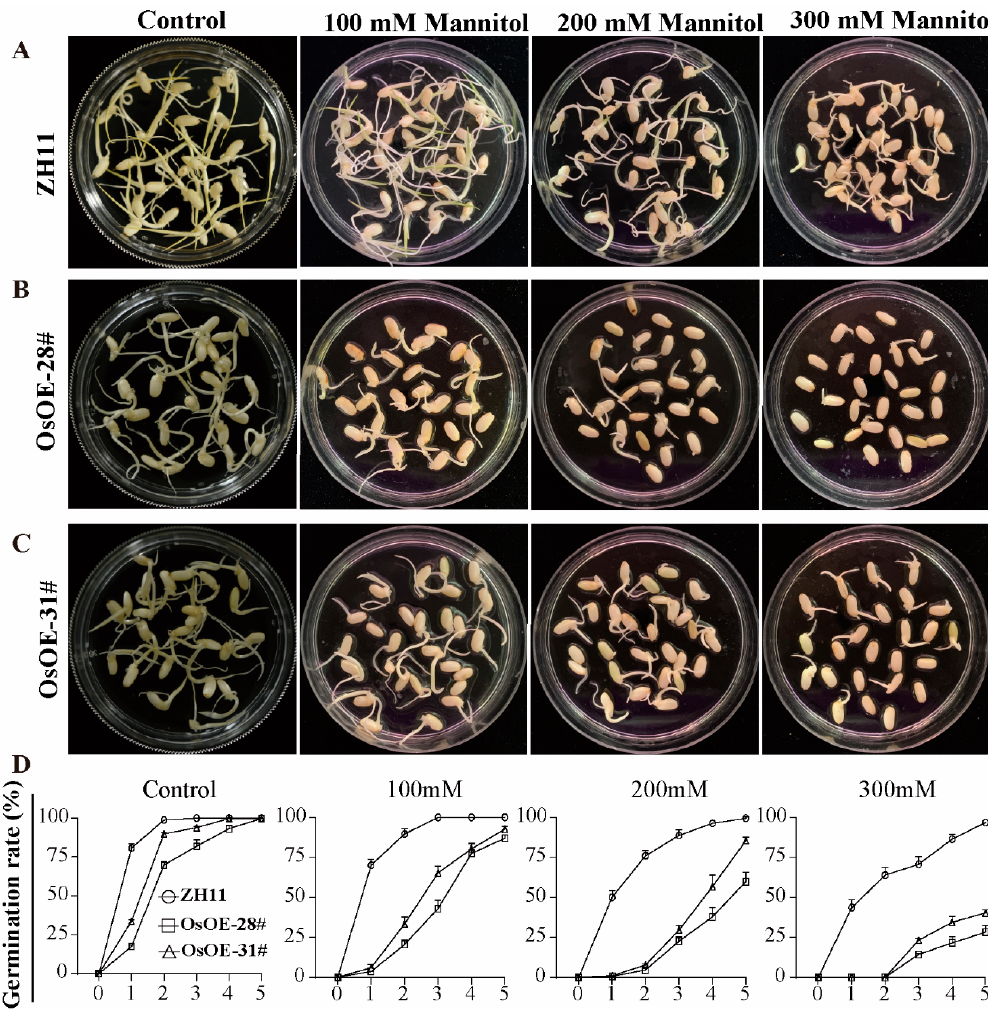
Figure 4. AcoMYB4 overexpression lines seed germination rate under mannitol treatment. Transgenic